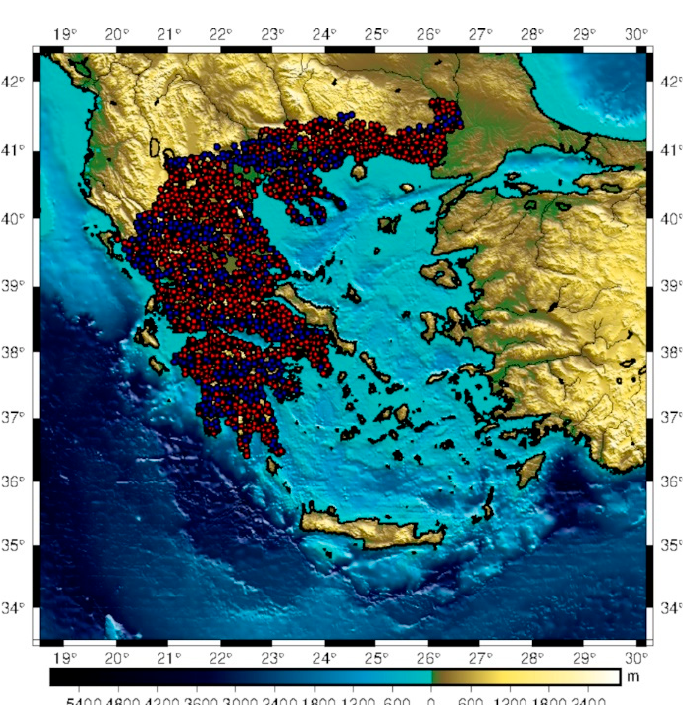
Figure 15. GNSS/levelling BMs with improved differences when using model i (blue dots) and BMs with no improvement (red dots).